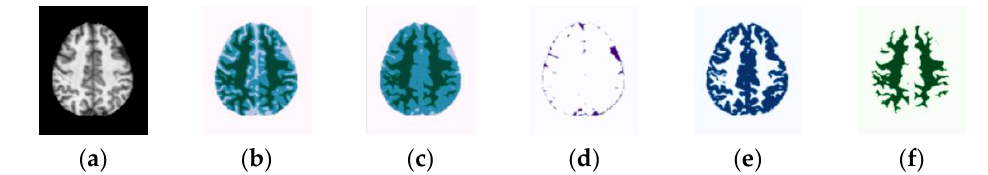
Figure 10. Segmentation results of the proposed method trained for the IBSR dataset and tested on OASIS data: ( a ) original input images, ( b ) ground-truth segmentation maps, ( c ) predicted segmen- tation maps obtained under the proposed method, ( d ) predicted binary maps of CSF, ( e ) predicted binary maps of GM, and ( f ) predicted binary maps of WM.